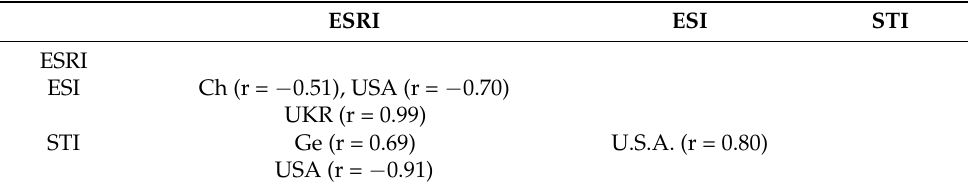
Table 3. Correlation analysis